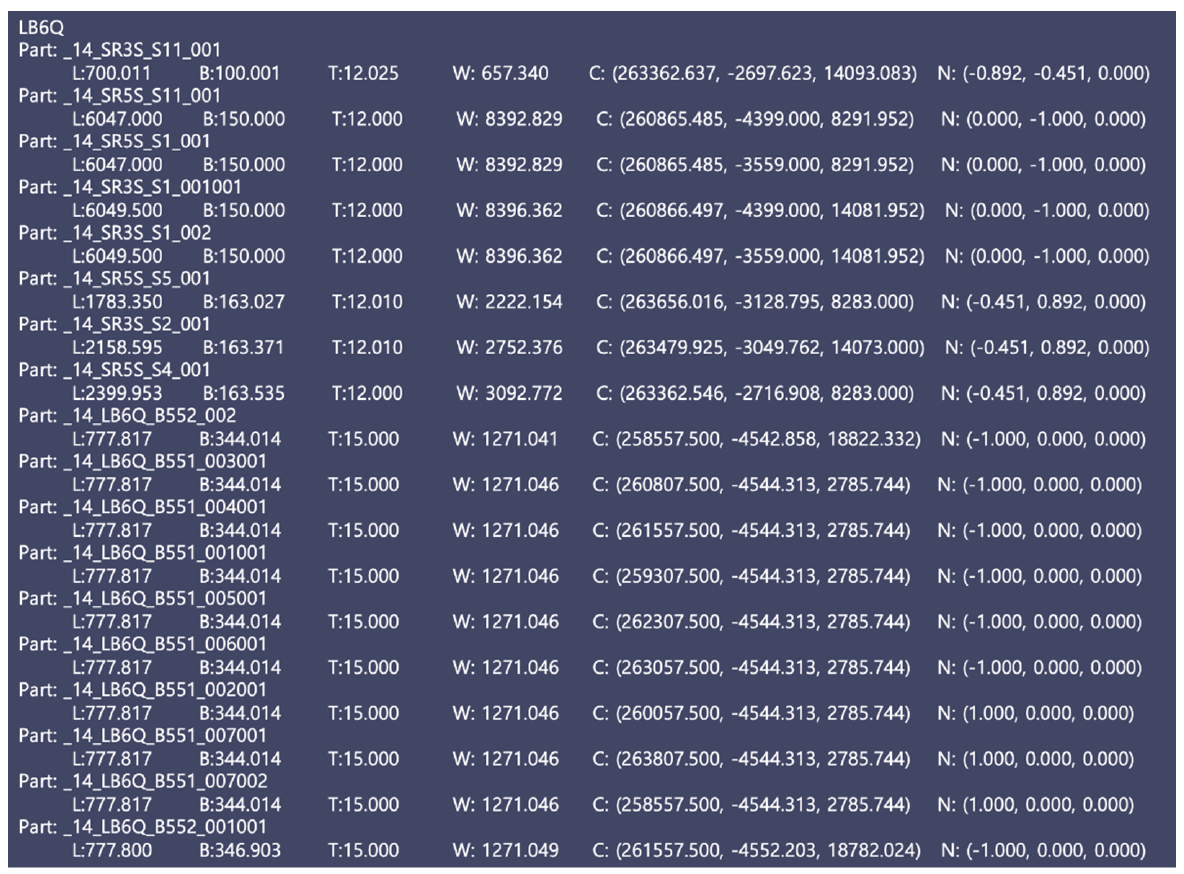
Figure 7. Geometric data of members: Length (L), breadth (B), thickness (T), centroid (C), and normal vector ( N ). Table 5. Results of metric calculation for detailed activities (excerpt). Route